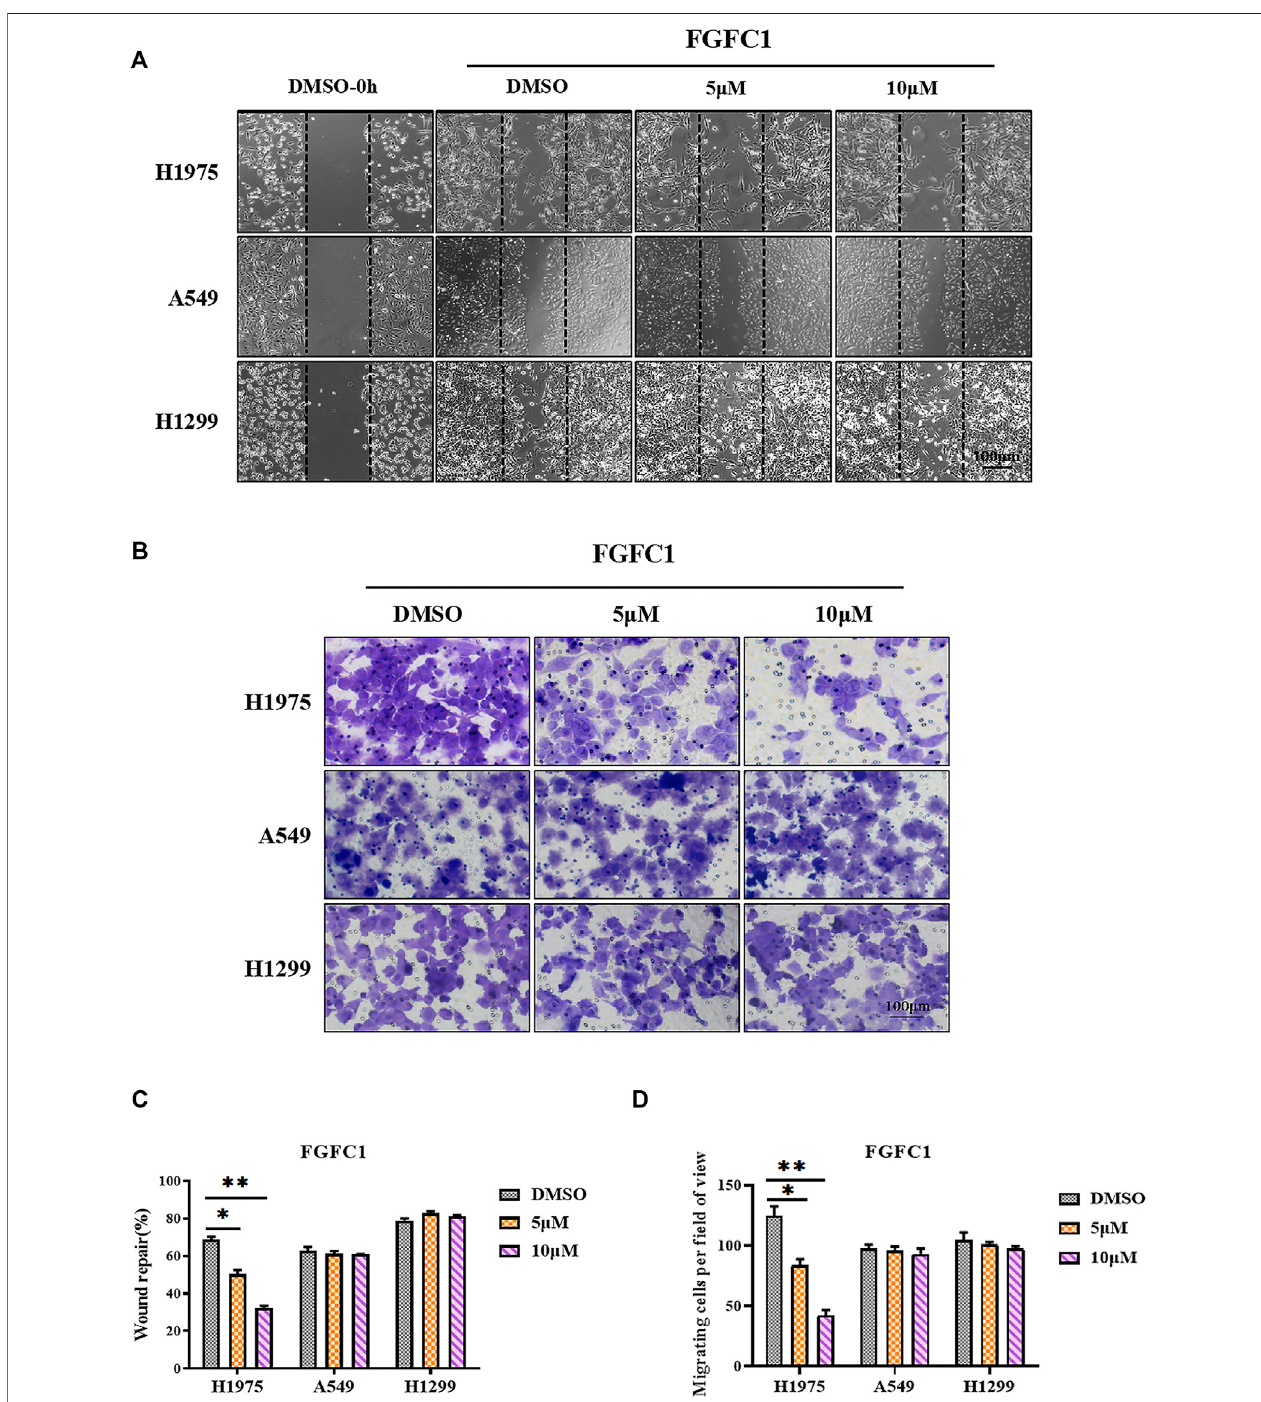
FIGURE5| FGFC1 selectivelyinhibited themigrationandinvasionofH1975 NSCLC cells. (A) ThemigrationofH1975,A549andH1299 cellswasevaluatedusing the scratch wound-healing assay after cells treated with indicated concentrations of FGFC1. NSCLC cells were seeded in 6-well plates and were treated with the indicated dose of FGFC1 (0, 5, and 10 μ M) for 24 h. Images of the results were obtained under microscope (200 × ) (scale bar (cid:1) 100 μ m). The migrated cells were quanti fi ed manually. (B) The invasion activity of H1975, A549 and H1299 cells treated with FGFC1 were measured by transwell invasion assay. NSCLC cells were seededin24-wellplatesandweretreatedwiththeindicatedconcentrationsofFGFC1(0,5,and10 μ M).After24 h,theinvasivecellswerestainedwithcrystalviolet,and photos were taken under microscope (200 × ). The invasion activity of these cells was measured by counting the staining positive cells (scale bar (cid:1) 100 μ m). (C) Quanti fi cation of the data in (A) . (D) Quanti fi cation of the data in (B) . All data were represented as the means ± SD for at least three independent experiments. ( *p < 0.05 and **p < 0.01 vs the DMSO control).